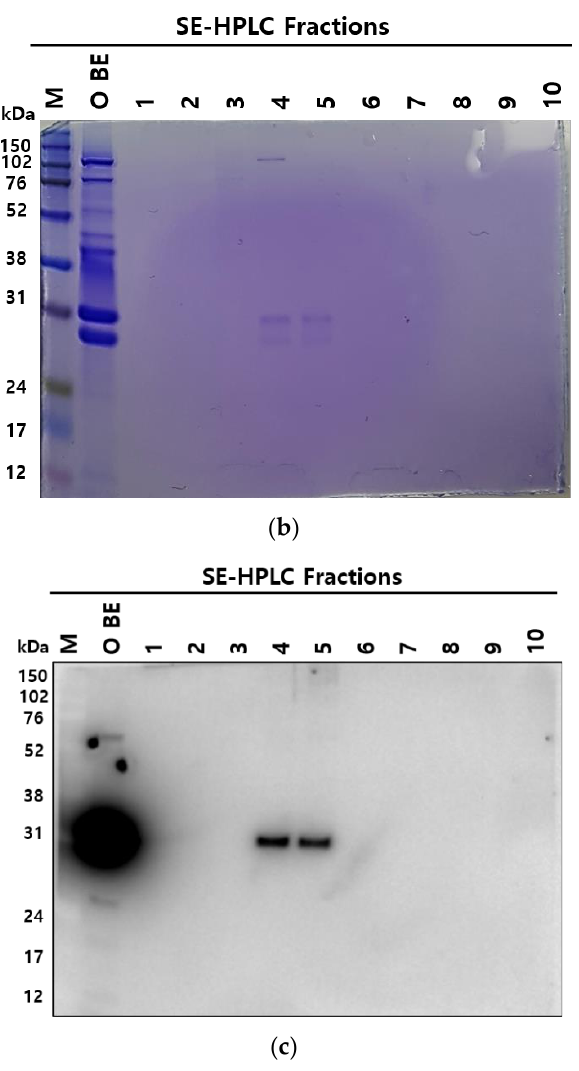
Figure 3. Narrow dispersion of vaccine antigens by SE-HPLC fractionation. ( a ) An original chromatogram from SE-HPLC fractionation of SDG-purified FMDV O BE vaccine antigen. Numbers underlined at the gray vertical lines indicate the starting point of each fraction number. ( b ) SDS-PAGE results of each SE-HPLC fraction from ( a ). FMDV O BE pure antigen was administered as a positive control. Between 24 and 31 kDa, bands of FMDV structural protein subunits are shown. ( c ) Western blot results of each SE-HPLC fraction from ( a ) using the VP1 antibody. VP1 bands were detected at approximately 31 kDa. Abbreviations: SDG, sucrose density gradient ultracentrifugation; SE-HPLC, size-exclusion high-performance liquid chromatography.